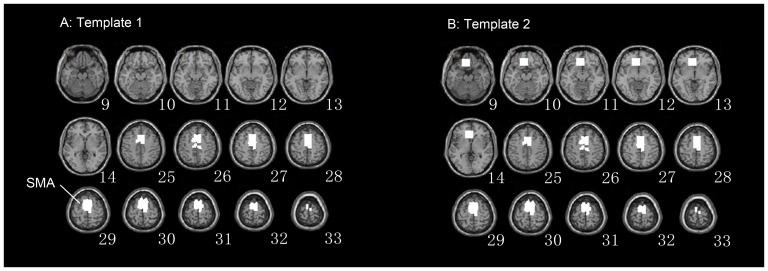
The spatial references that were used in the real fMRI data.(A) The ROIs in the first spatial reference. (B) The ROIs in the second spatial reference.